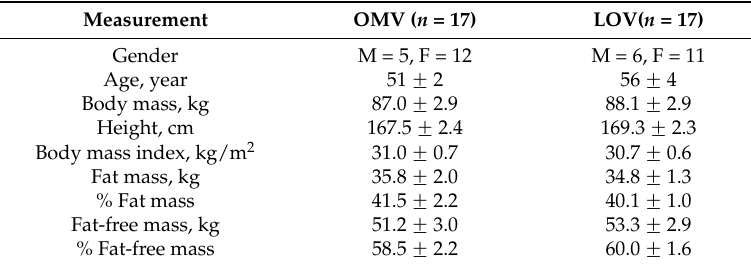
Table 1. Baseline subject